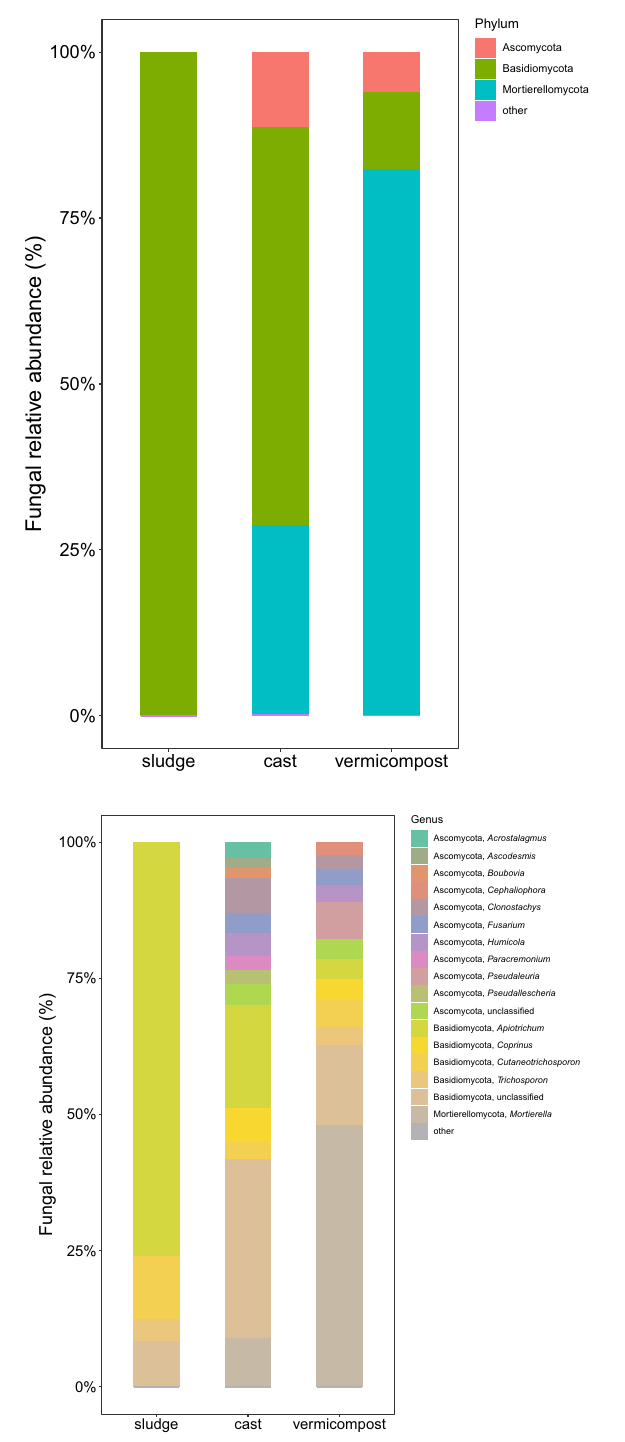
Figure 2. Relative abundance of the main phyla and genera of fungi in sewage sludge, fresh earthworm casts and vermicompost (3 months old) during vermicomposting of sewage sludge. Low abundance bacterial phyla and genera (< 1%) were grouped together